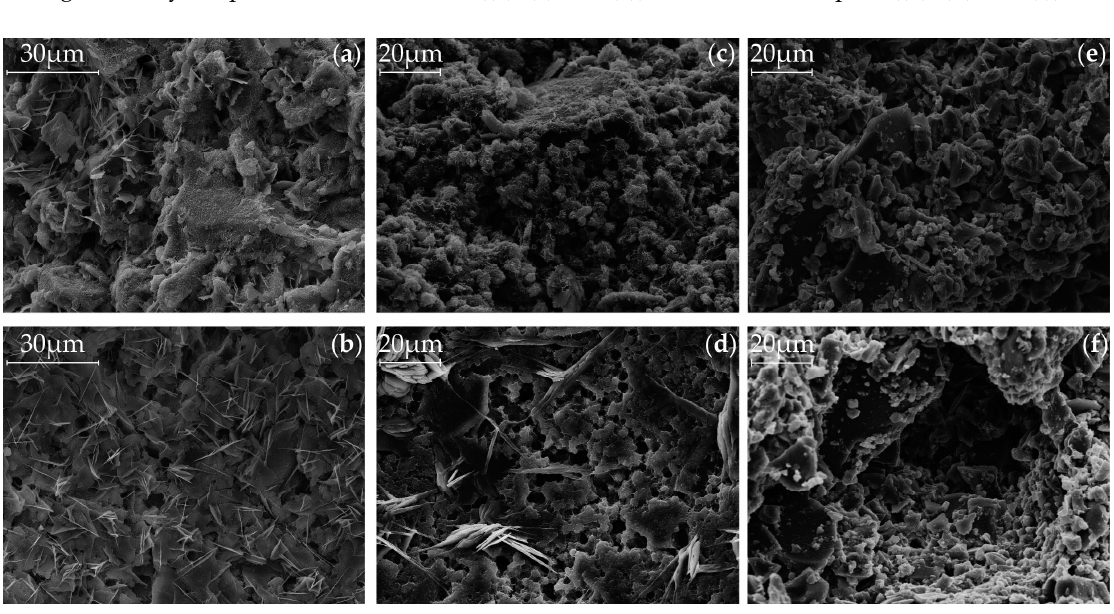
Figure 7. SEM pictures after a hydration period of seven days, of the reference (( a ) of surface and ( b ) of pore) and the reactivated mixtures with Ac1 after seven days of retardation (( c ) of surface and ( d ) of pore with 0.25%R, ( e ) of surface and ( f ) of pore with 1.00%R).